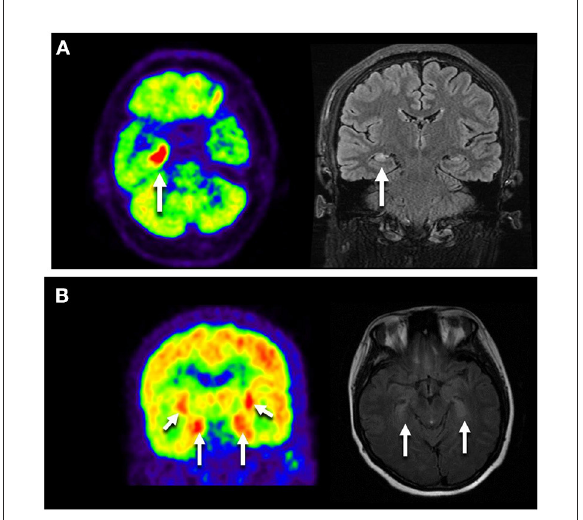
FIGURE2 Neuroimages of the GAD65 antibody associated neurological disorders. (A) Images of NO.9 who presented with Ep. Axial FLAIR MRI showed right temporal hyperintensity, and Axial FDG-PET/CT scan showed hypermetabolic right mesiotemporal spot (white arrow). (B) Images of NO.41 who manifested as